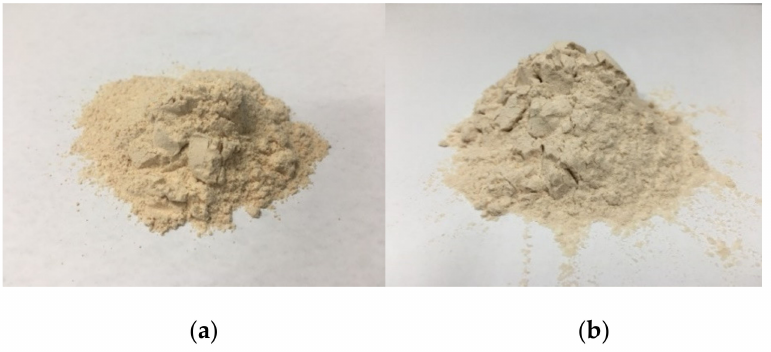
Figure 1. Appearance of banana starch ( a ) M. acuminata (AAA; HK) ( b ) M. sapientum L. (ABB;